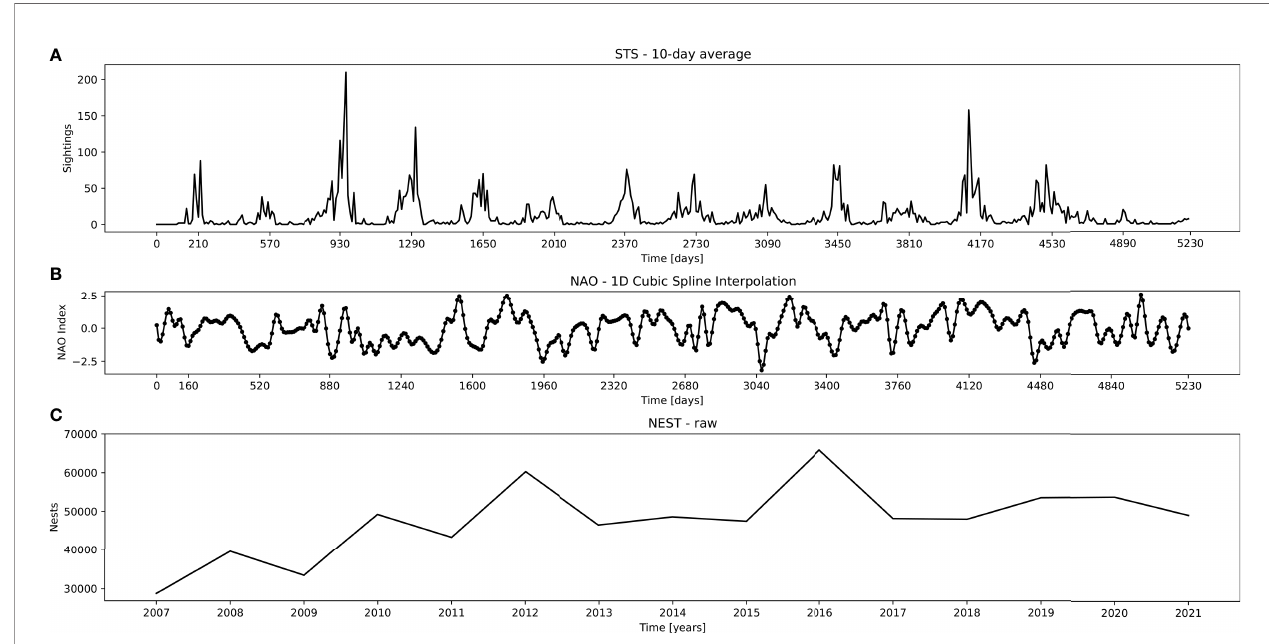
FIGURE 2 | Used datasets, top to bottom: (A) STS – 10-day average points of sea turtle sightings, (B) NAO – interpolated NAO index average air pressure, and (C) NEST – yearly nesting of loggerhead sea turtles in peninsular Florida. Abscissa depicts points matching the sampled STS period (from 2007 - 01 to 2021 -